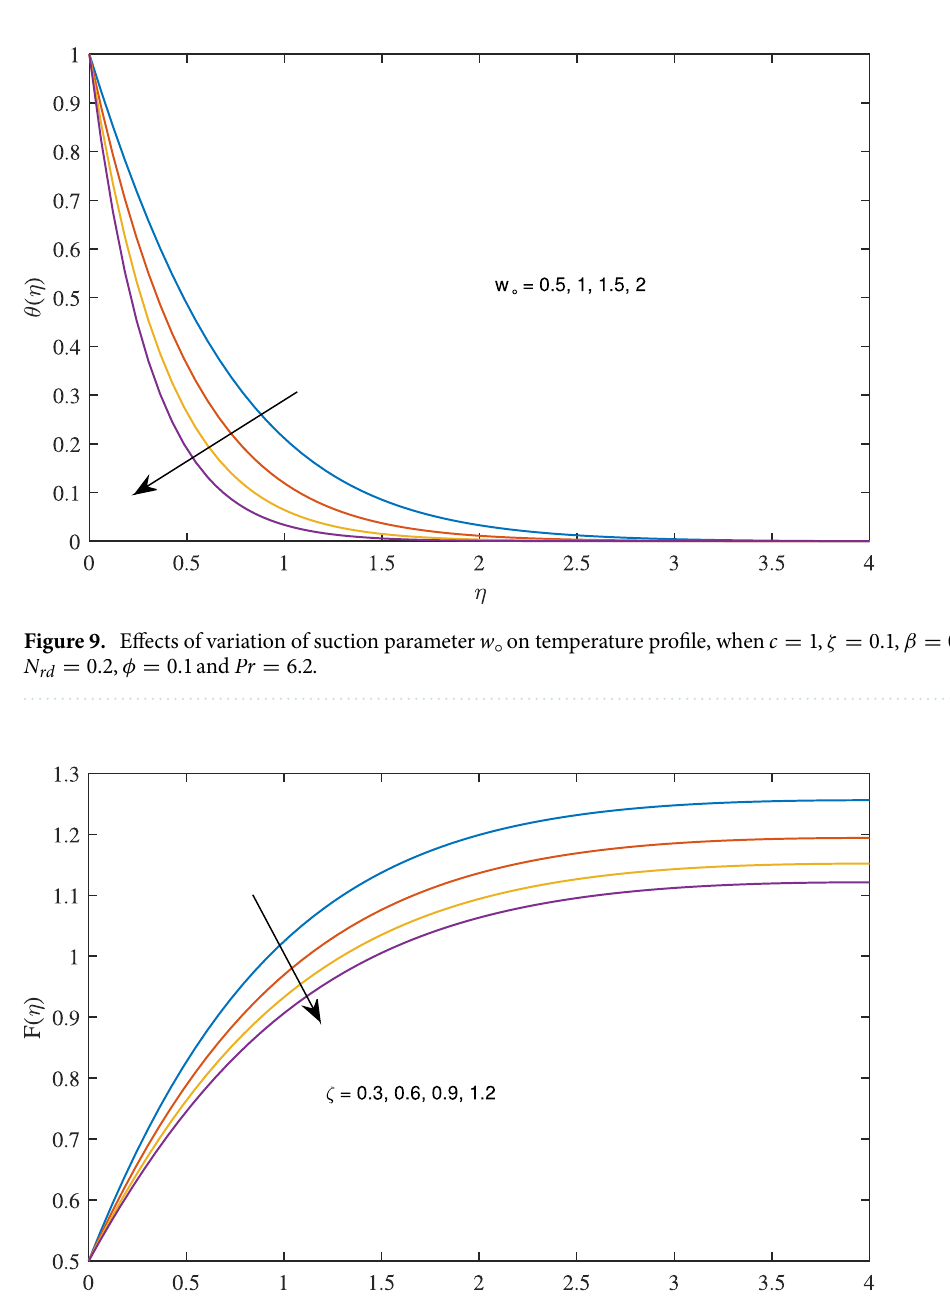
1 , w 0.1 and 0.5 , β 0.2 , N 0.2 , φ rd = = = = ◦ =